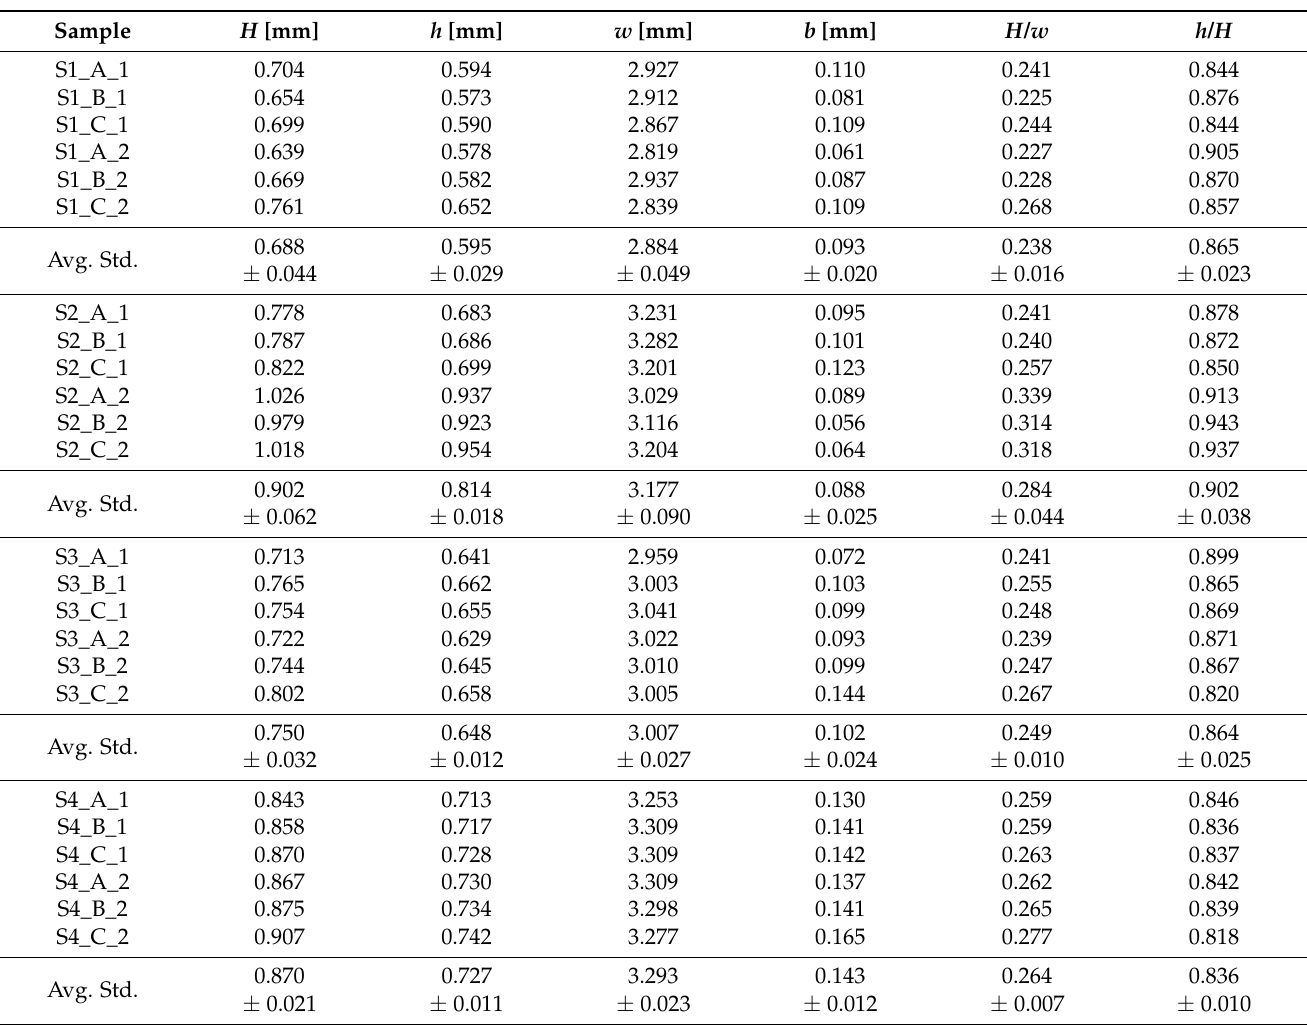
Table 5. Geometrical features measures of the samples performed [A: track A, B: track B, C: track C], [1: zone 1, 2: zone 2]. Avg. is the average value, and Std. is the standard